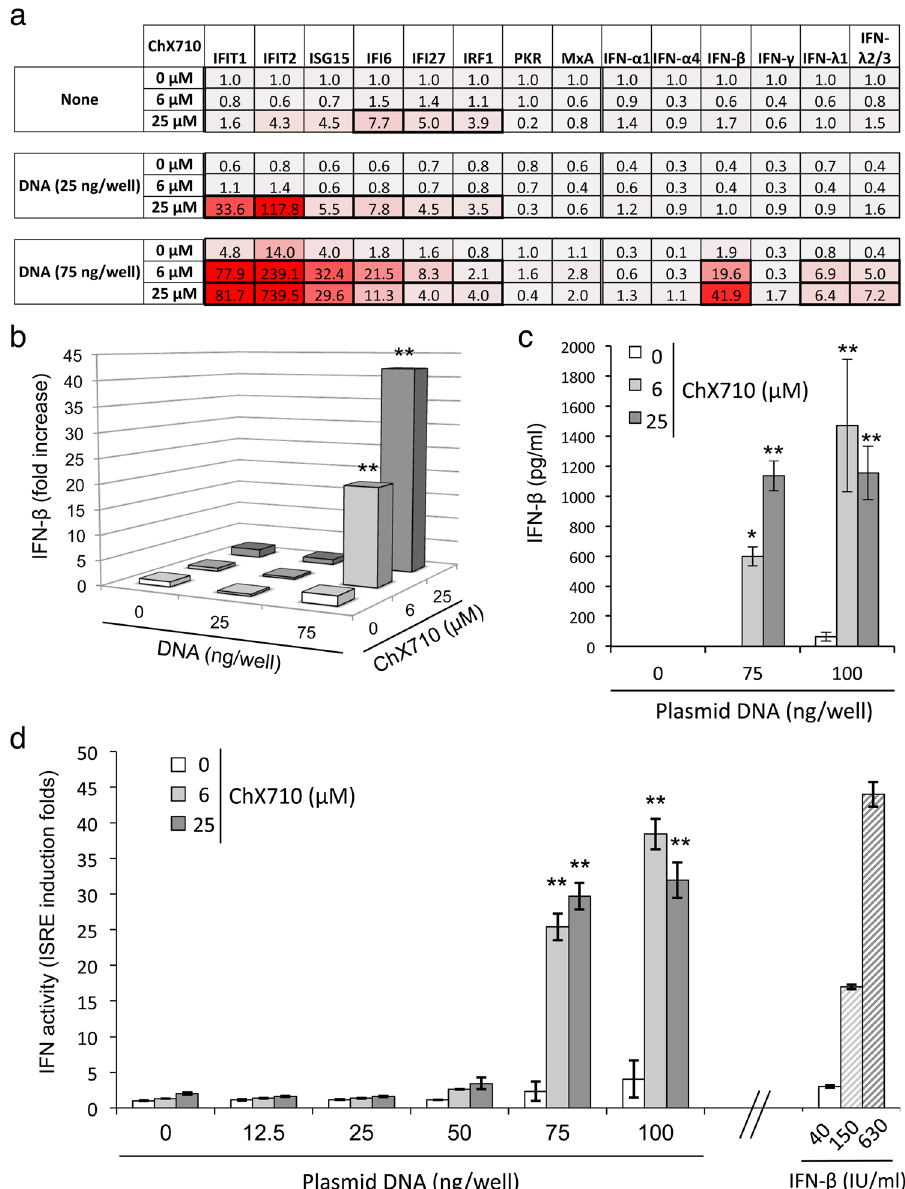
Figure 7. Synergistic induction of ISGs and IFN- β by DNA transfection and ChX710. ( a ) ISRE-luciferase reporter cells were transfected with 25 or 75 ng/well of plasmid DNA (pCiNeo-3xFlag-GW), and cultured at 4 × 10 4 cells/well in 96-well plates with DMSO alone or ChX710 at 6 or 25 μ M. After 24 hours of incubation, total RNA were extracted and expression levels of specified genes were determined by RT-qPCR. Data were normalized with using RPL13A mRNA expression as reference, and expressed as induction folds relative to DMSO-treated cells using the 2 −ΔΔ Ct method. Induction folds > 3 that are statistically significant between untreated and ChX710-treated wells are framed with bold lines (two-way ANOVA and Bonferroni’s post hoc test; P < 0.05). ( b ) Data corresponding to IFN- β mRNA expression levels as in (A) are presented as 3D histograms to highlight the synergistic effect of DNA transfection and ChX710 treatment. ( c ) HEK- 293 cells were transfected with 75 or 100 ng/well of plasmid DNA (pCiNeo-3xFlag-GW), and cultured at 4 × 10 4 cells/well in 96-well plates with DMSO alone or ChX710 at 6 or 25 μ M. After 48 hours of incubation, culture supernatants were recovered, tested for IFN- β concentration by ELISA. ( d ) Same as in ( c ) but culture supernatants were applied at a ½ dilution to fresh ISRE-luciferase reporter cells to determine interferon activity. As a reference, reporter cells were stimulated with recombinant IFN- β at 40, 150 or 630 IU/ml. After 24 hours of incubation, luciferase activity was determined. Data represent means ± SD of three independent experiments. * P < 0.05 and ** P < 0.01 correspond to statistically significant differences between untreated and ChX710- treated wells (two-way ANOVA and Bonferroni’s post hoc